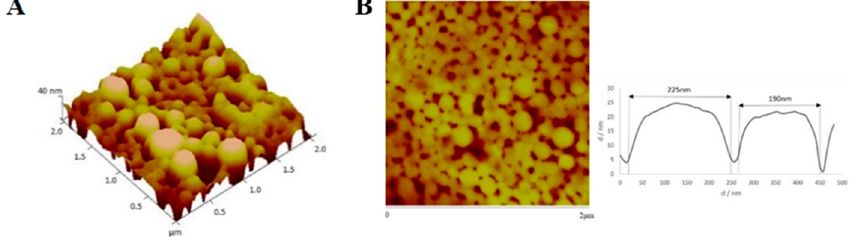
Figure 10. AFM images (3D and sectorial images) with size scale of ( A ) PvD-loaded, and ( B ) empty non-conjugated NPs.